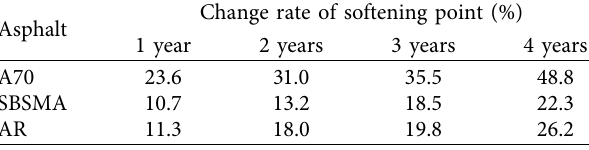
Table 4: Change rate of softening point.